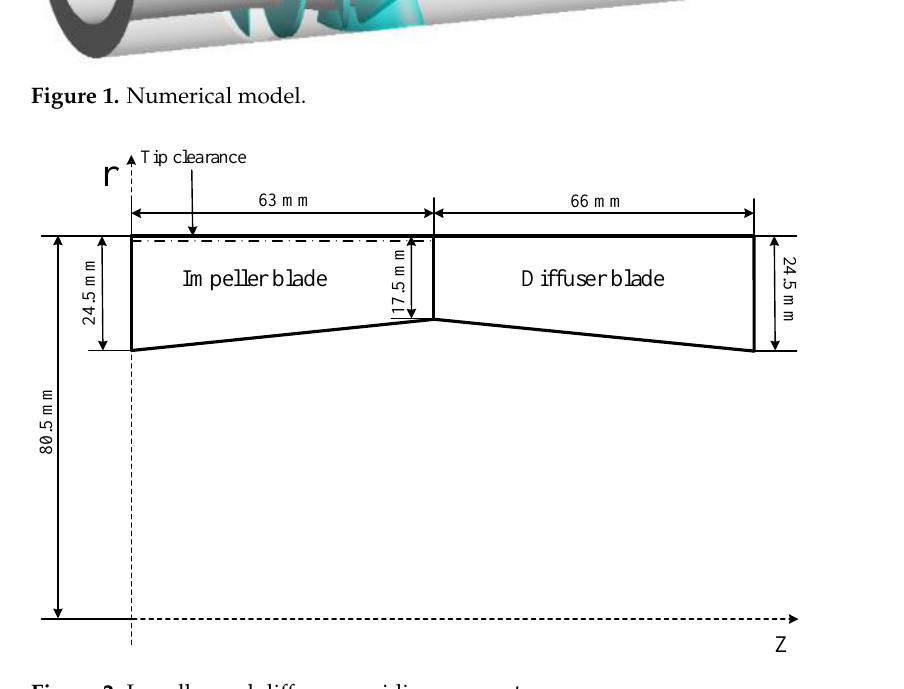
Figure 2. Impeller and diffuser meridian parameters.